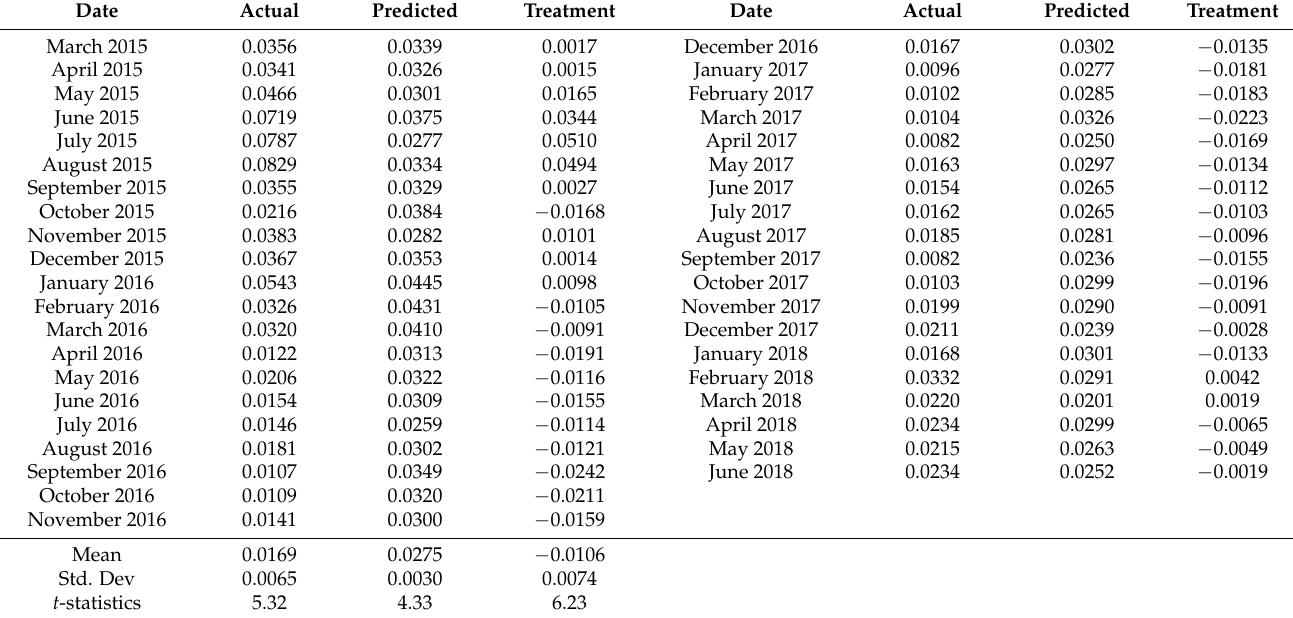
Table 5. Treatment effect from LASSO